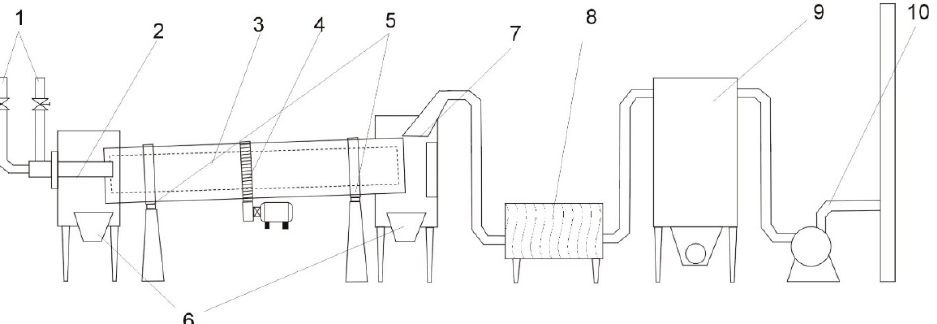
Figure 7. Diagram of the laboratory furnace used in the research: 1—Natural gas and air supply; 2—burner; 3—rotary kiln; 4—furnace drive; 5—rollers enabling rotary movement; 6—chute hoppers (return, burnouts); 7—process gas collector; 8—process gas cooler; 9—pulse fabric filter; 10—fan with a chimney system.